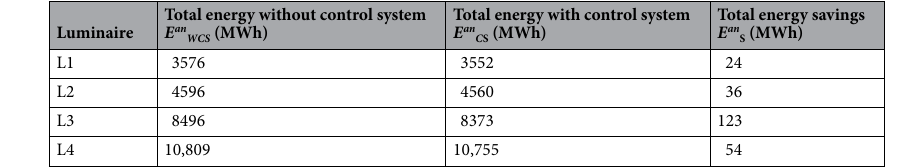
Table 6. Total electricity consumption and savings per 20,000 luminaires and 15 years performance.